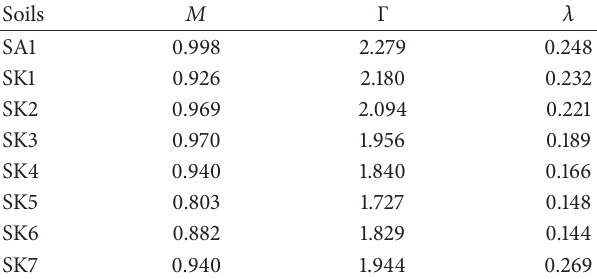
Table 5: The critical state